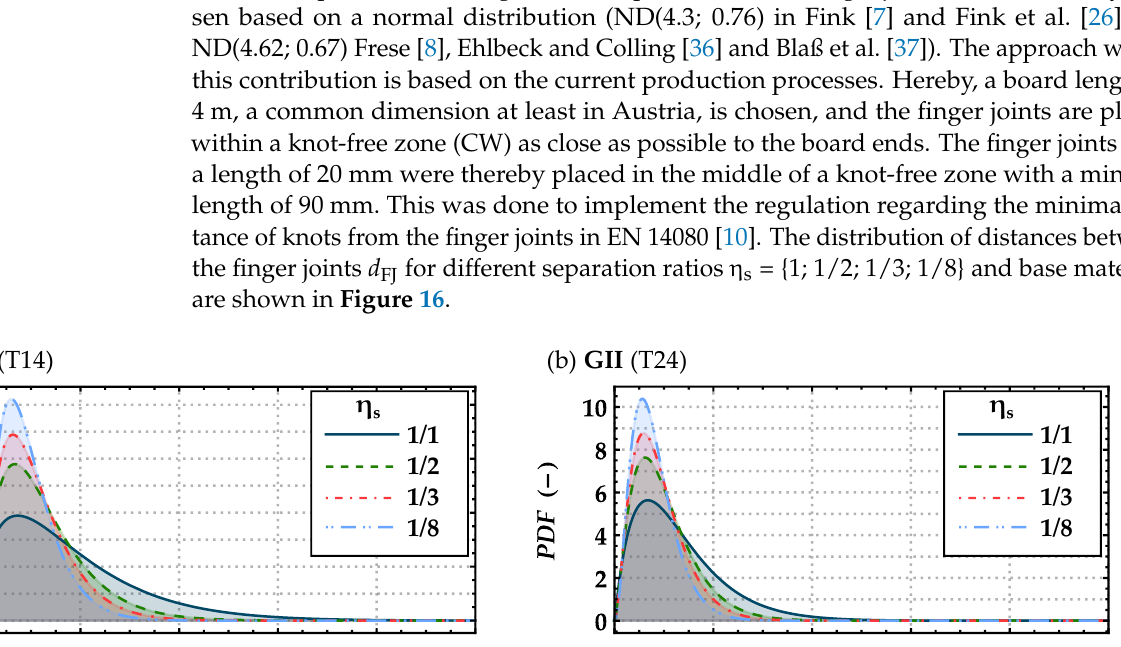
Figure 15. Histograms together with calibrated lognormal density functions of the finger joint tensile strength parallel to the grain f t,FJ in (MPa) for both groups GI and GII.